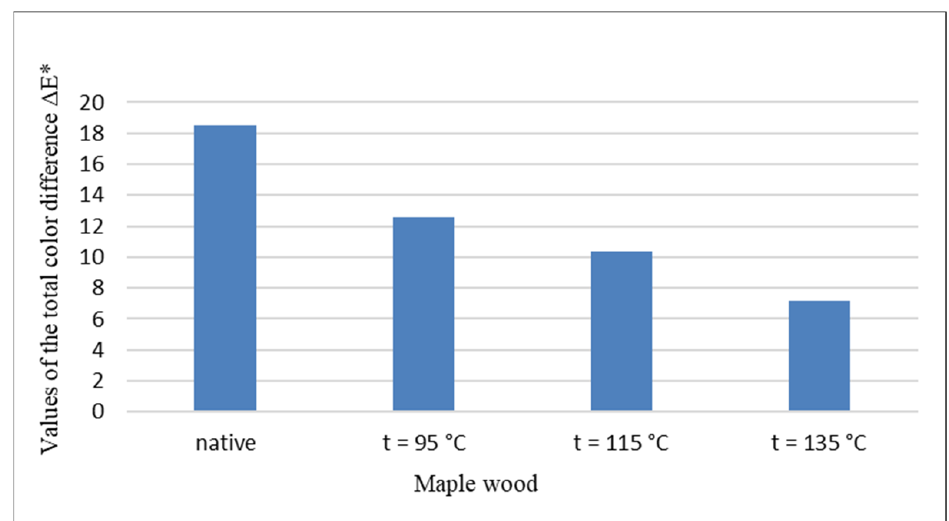
Figure 5. Influence of UV radiation on the size of the total color difference ∆ E* of unsteamed and steamed maple wood.